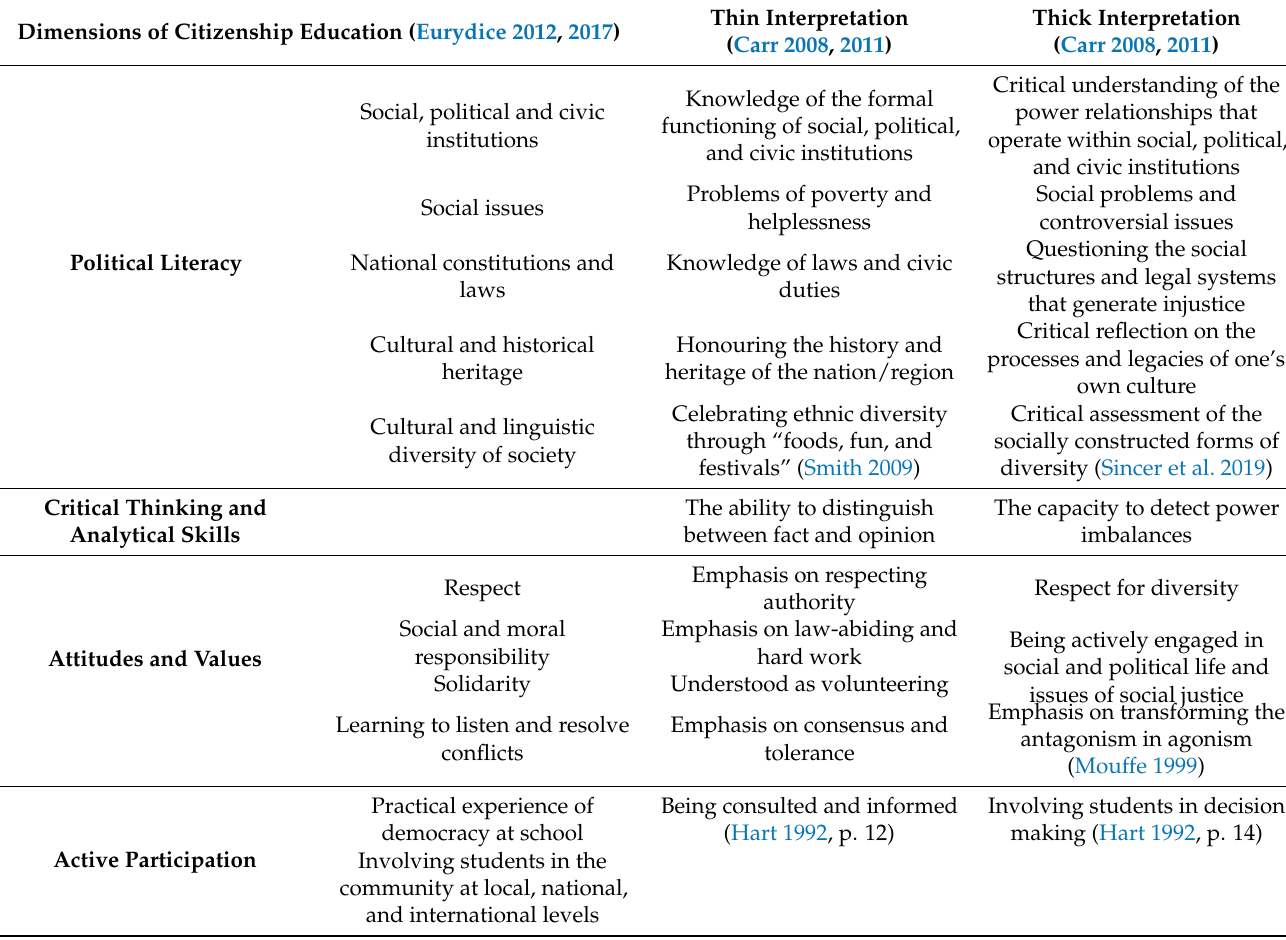
Table 2. Framework used for the qualitative data